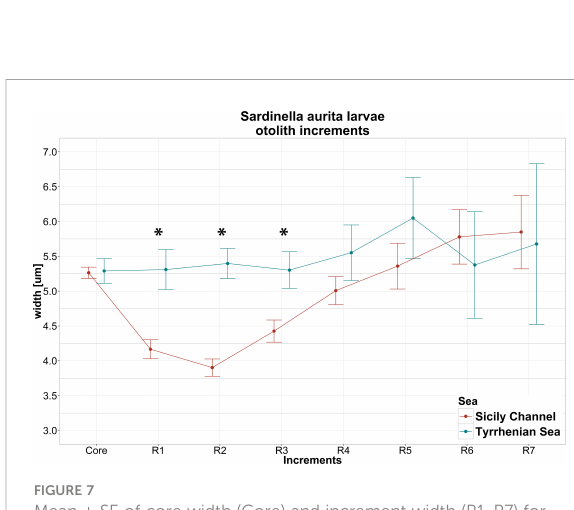
FIGURE 7 Mean ± SE of core width (Core) and increment width (R1-R7) for larvae collected in Sicily Channel and Tyrrhenian Sea. The signi fi cance of Mann – Whitney U test (*= p<0.01) implemented between regions is also